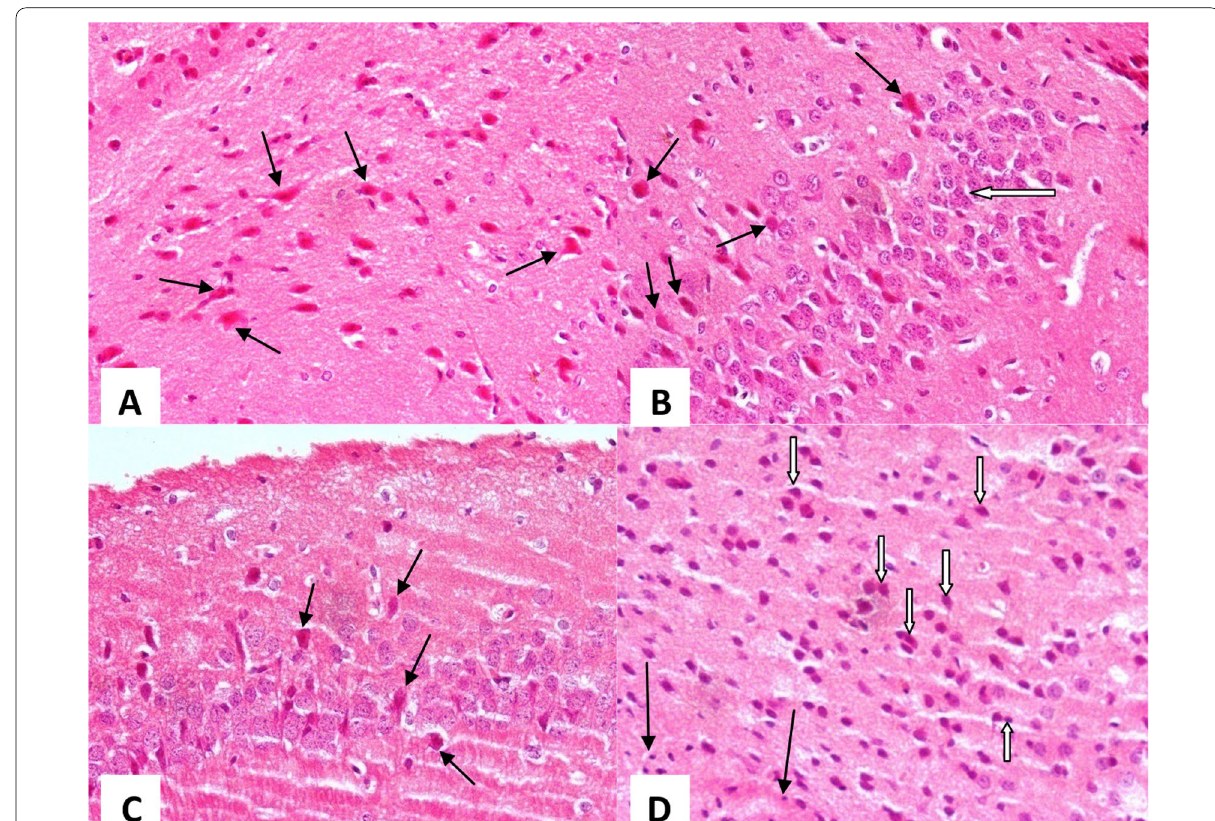
Fig. 6 A Brain tissue of mice treated with ( l -dopa PQ) showing restoration of cellularity with numerous neuronal pyramidal cells showing + brownish pigment within cytoplasm (black arrows). B Brain tissue of mice treated with ( l -dopa PQ) showing restored cellular Purkinje cell layer + (white arrow) with numerous pigmented neuronal cells (black arrows) (H&E X 400). C Brain tissue of mice treated with (R PQ) showing cellular, + restored Purkinje cell layer with several prominent pigmented neuronal cells (black arrows). D Brain tissue of mice treated with (R PQ) showing + dense cellularity, scattered cells appeared with irregular contours and deeply basophilic, hyperchromatic nuclei (white arrows). Still, some pyknotic nuclei were seen (thin black arrows) (H&E